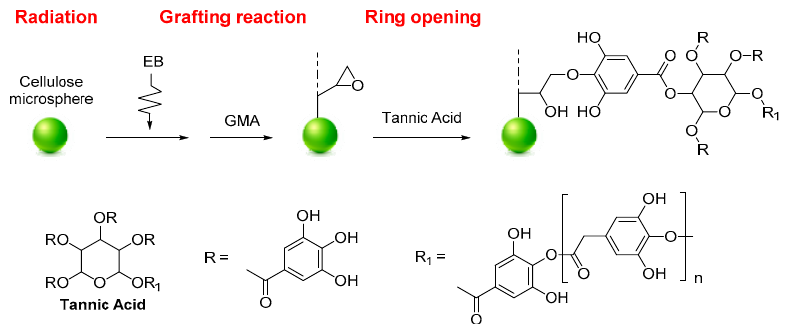
Figure 5. Synthesis of